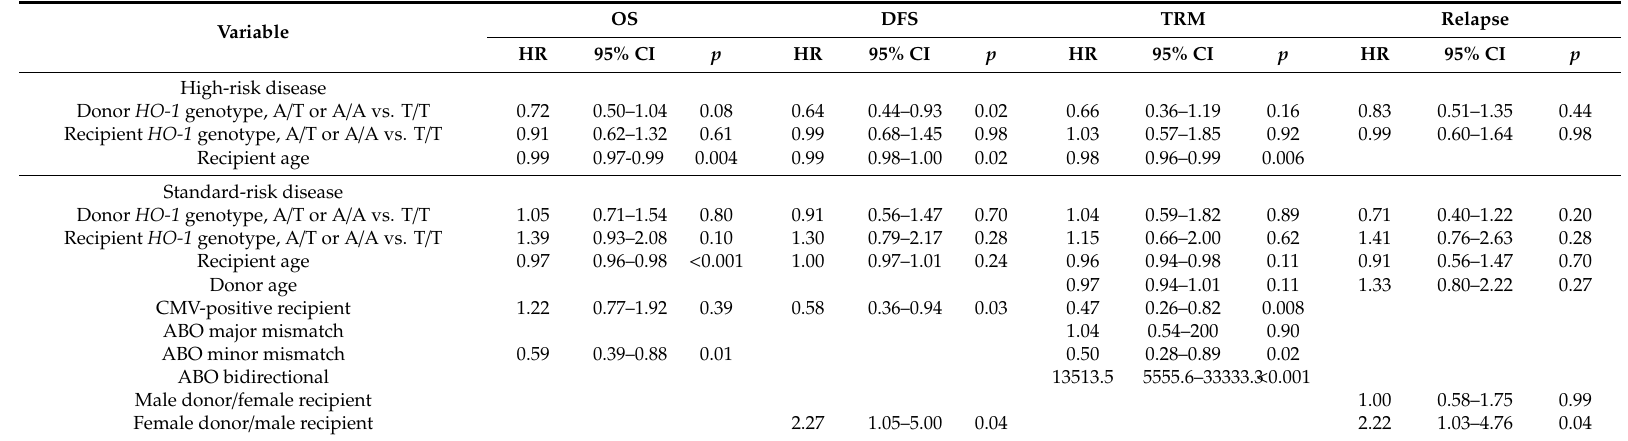
Table 2. The results of the multivariate analysis of the association between the HO-1 genotype and the clinical outcomes after transplantation (first part). OS DFS TRM Relapse Variable